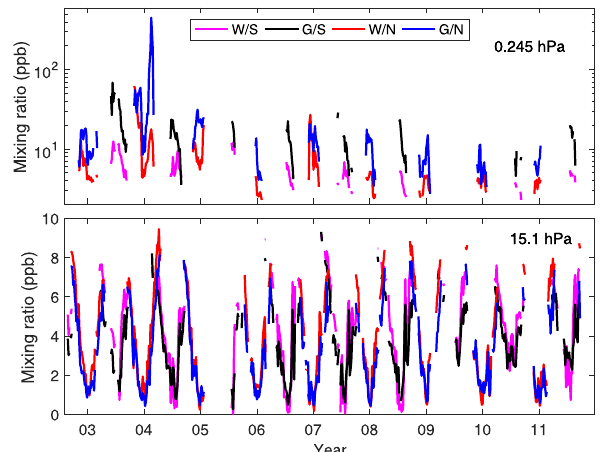
Figure 10. WACCM and GOMOS NO 2 mixing ratio correlation over 2002–2011. Latitudes are from − 90 to 90 ◦ with 10 ◦ resolution. A crossed cell marks a point where the correlation does not deviate from zero in a statistically significant way. A cell with a dot marks a point where there are no collocated profiles.